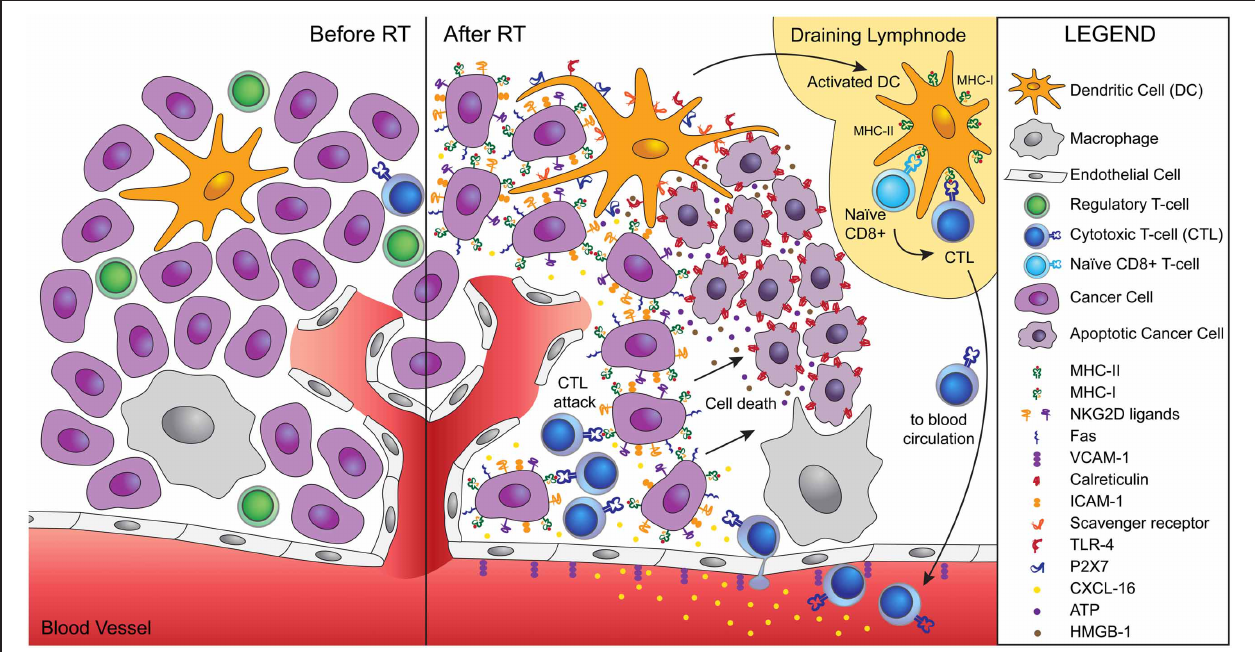
antigens. Activated CD8 T cells acquire effector functions and traffic to the tumor guided by radiation-induced chemokines. Tumor infiltration by CTLs is facilitated by radiation-induced upregulation of VCAM-1 on the vascular endothelium. Once in the tumor, CTLs interact efficiently with tumor cells expressing increased levels of MHC-I, ICAM-1, NKG2D ligands, and Fas that promote the formation of stable immunological synapses between targets and effectors and facilitate the killing of tumor cells by CTLs. Tumor cells killed by CTLs become a source of antigens for cross-presentation, thus fueling the